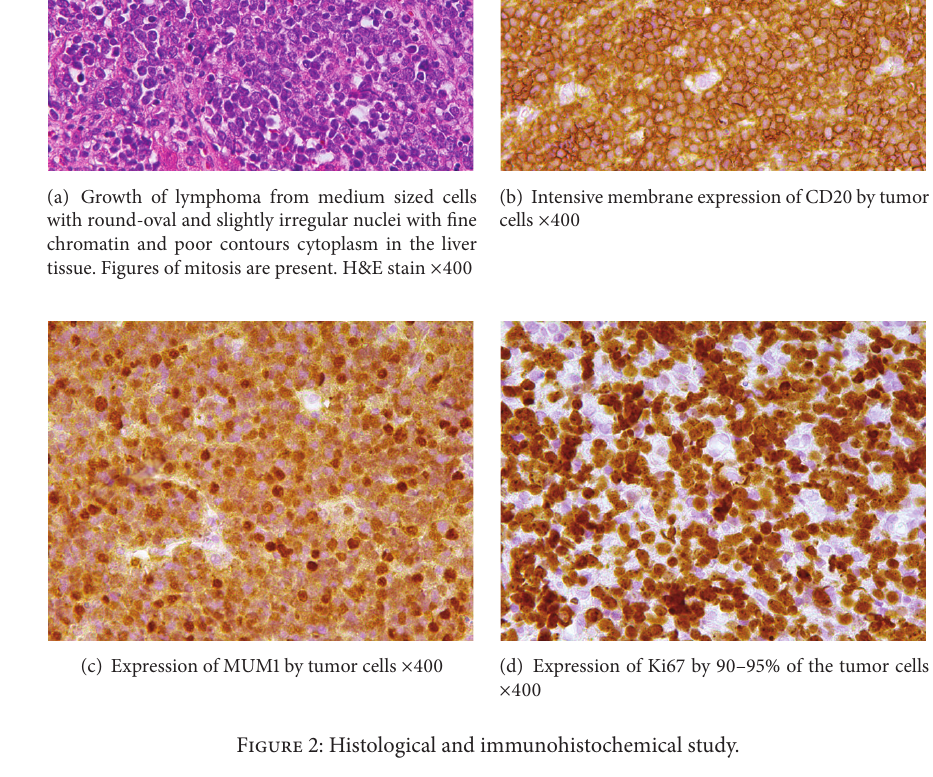
Figure 2: Histological and immunohistochemical